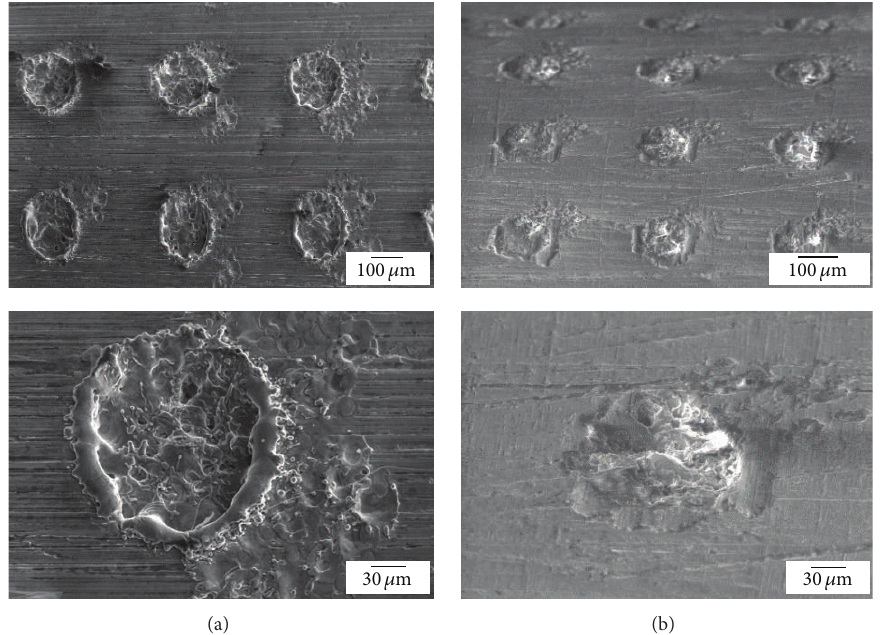
Figure 15: SEM images of die radius—texture #3: (a) before and (b) after hot stamping tests.